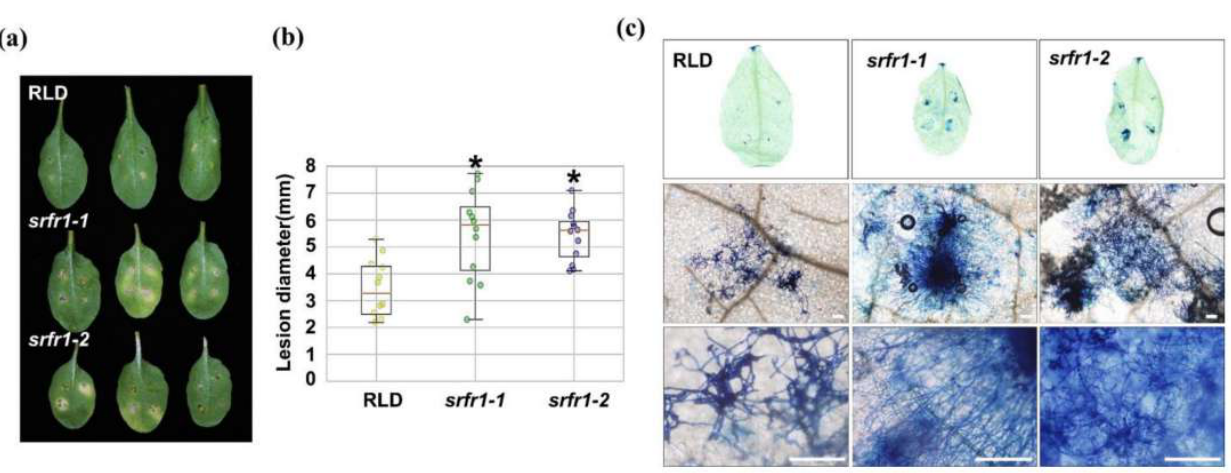
Figure 2. Response of Arabidopsis srfr1 mutants to the necrotrophic fungal pathogen, Botrytis cinerea. ( a ) Fungal spores of B. cinerea grown on PDA were harvested and inoculated onto detached leaves of Arabidopsis RLD, srfr1-1, and srfr1-2 mutants at a concentration of 1 × 10 8 spores/mL. Photographs were taken at 5 DPI; ( b ) box plots of lesion size at 5 DPI in RLD, srfr1-1 , and srfr1-2. The y-axis displays the measured diameter of disease lesions (mm, n = 12) in each plant. The box ranges were determined from the twenty-fifth to the seventy-fifth percentiles. A statistically significant difference was determined by the Student’s t -test (* p < 0.01); ( c ) leaves were collected 3 DPI with B. cinerea and stained with lacto-phenol trypan blue to visualize the extent of hyphal development. Scale bar: 200 µ m.